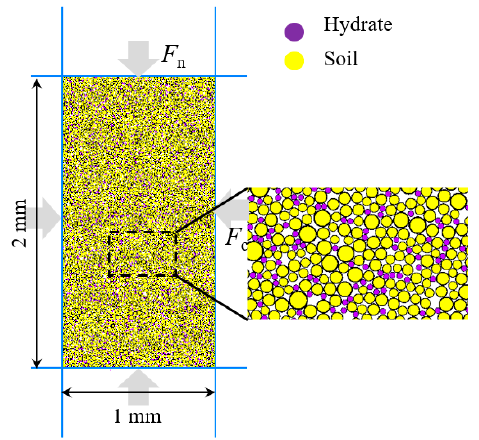
Figure 7. Biaxial discrete element numerical model and microstructure of gas hydrate deposits.